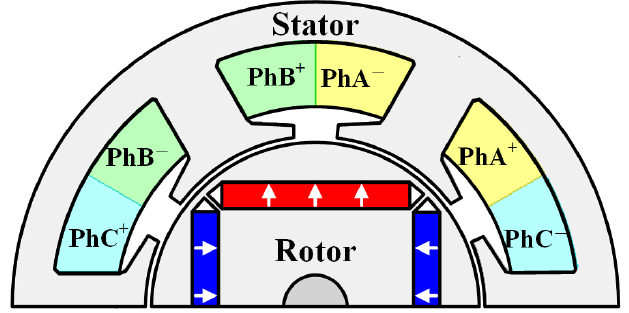
Figure 2. The shape of analysis model. Figure 1. The actual model used for the equivalent magnetic circuit analysis.